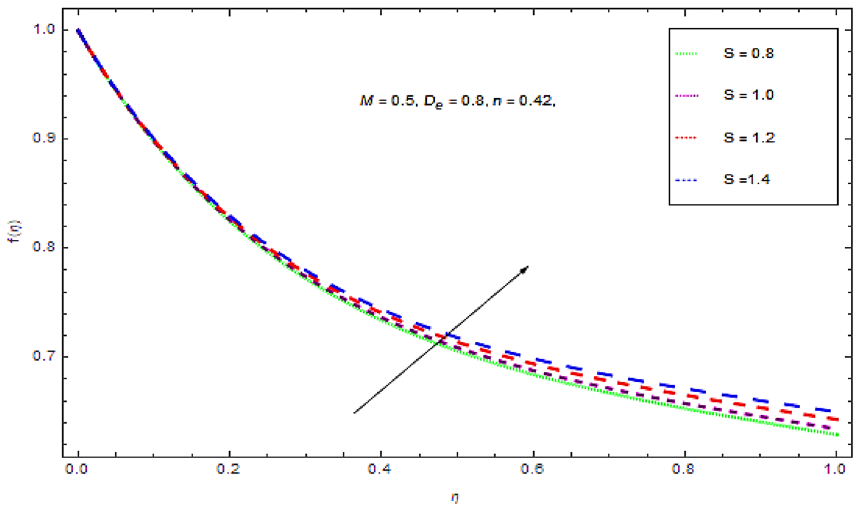
Figure 6. Outcome of S on f (η) .